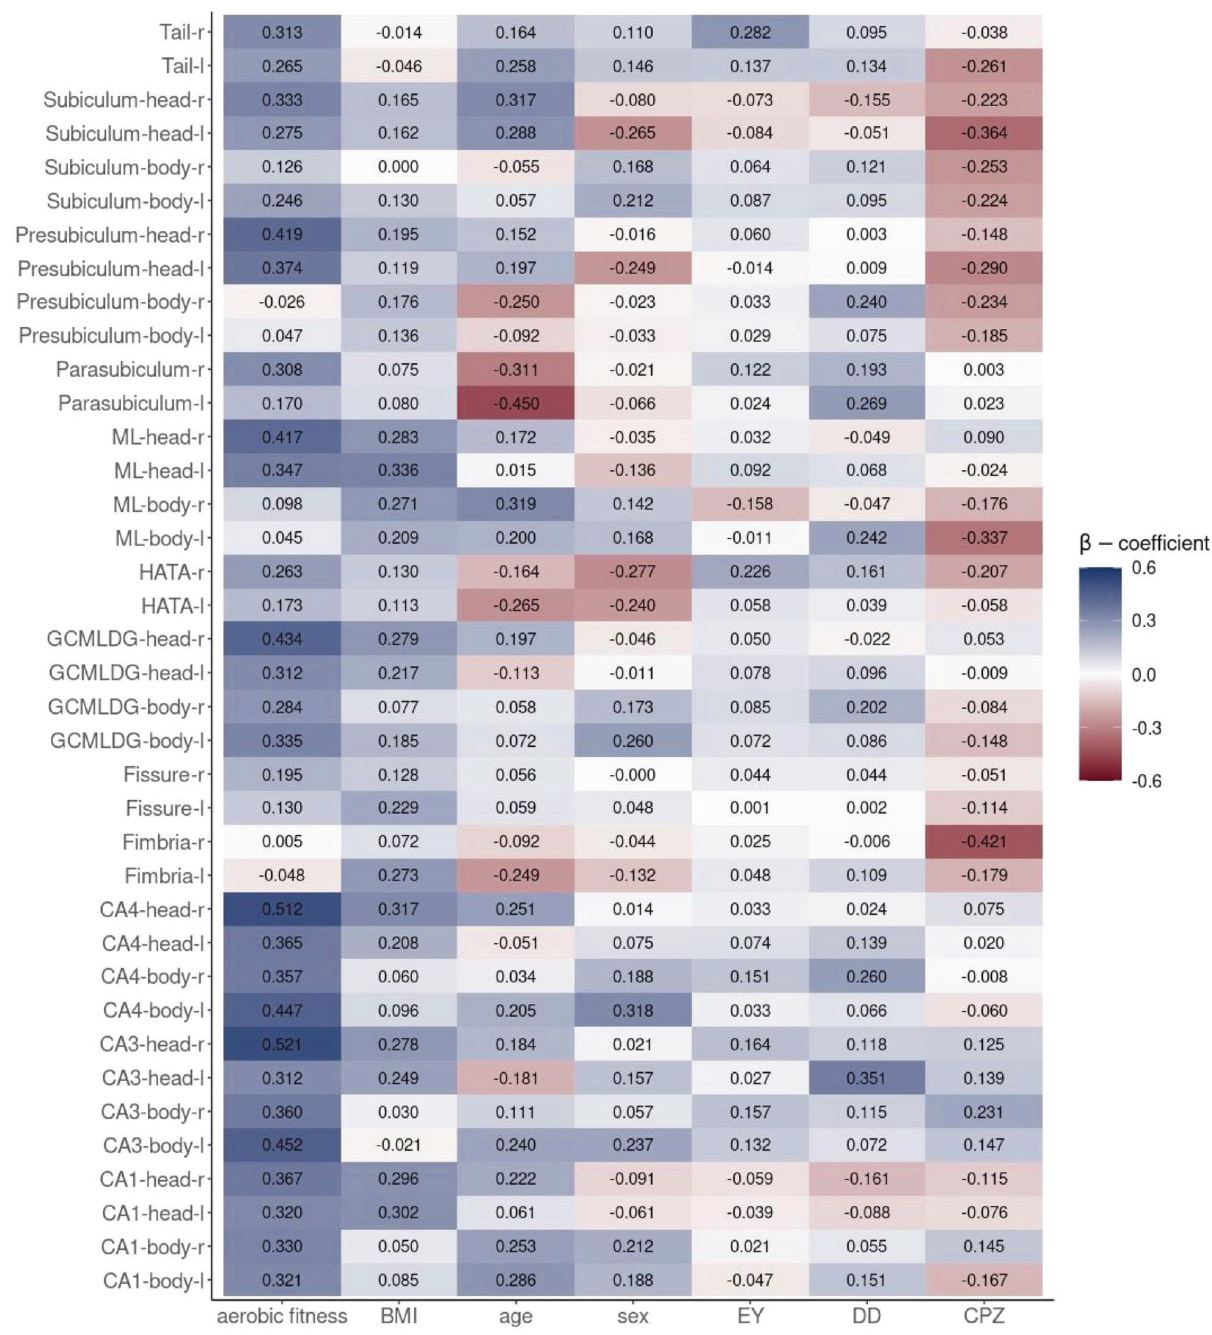
Fig. 2 β -coef fi cients of aerobic fi tness and the covariates predicting volumes of the hippocampal formation sub fi elds. The x-axis shows the predictors of the multivariate multiple linear regression, and the y-axis, the 38 hippocampal formation sub fi elds from both hemispheres. The heatmap is fi lled with the β -coef fi cients. Blue indicates a positive effect, red a negative effect. The darker the color, the stronger is the effect in the corresponding direction. BMI body mass index, CA cornu ammonis, CPZ chlorpromazine equivalents, DD disorder duration, EY education years, GCMLDG granule cell and molecular layer of the dentate gyrus HATA hippocampal amygdala transition area, l left hemisphere, ML molecular layer, r right